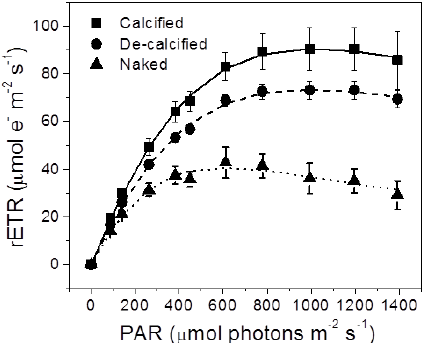
Figure 3. The relative electron rate (rETR) of calcified, decalci- fied and naked cells of E. huxleyi grown under indoor conditions as function of PAR. The cells were grown for 12–22 generations under 500µmolphotonsm − 2 s − 1 of PAR.